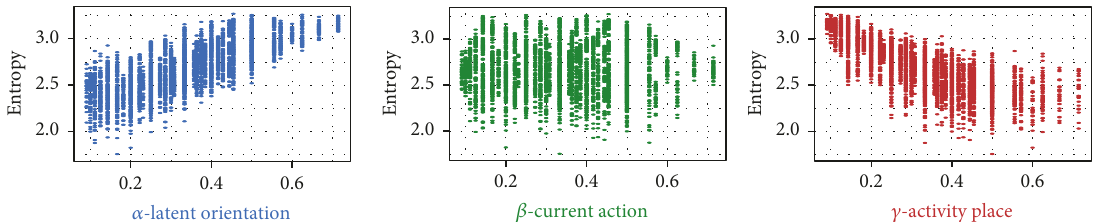
Figure 9: Parameter exploration: isolated importance of each parameter in entropy (under the friction of distance). Each vertical set of dots represents one fixed value for the highlighted parameter, with the two other parameters assuming every possible combination within the tested range. Each dot corresponds to the entropy value when a sufficiently large time-frame is